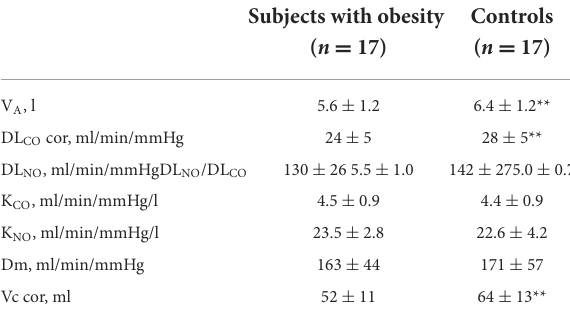
TABLE 3 Lung diffusion capacity at rest.